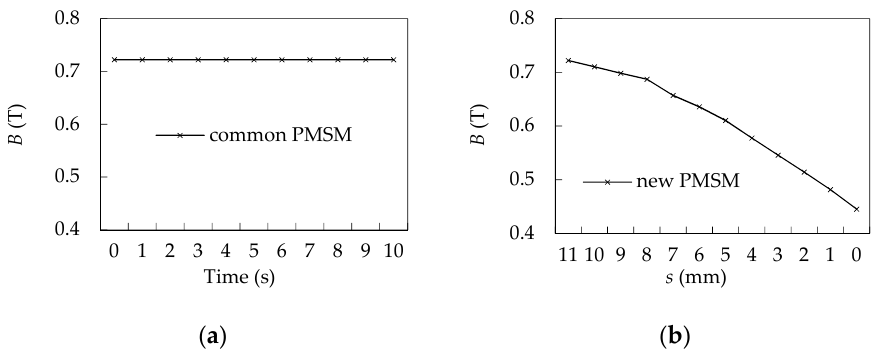
Figure 19. The no-load air-gap magnetic flux density ( n = 1500 r/min): ( a ) the magnetic flux density versus time for the common PMSM; ( b ) the magnetic flux density versus s for the new PMSM. The no-load back EMF of the common PMSM and the new PMSM is shown in Figure 20. The no-load back EMF of the common PMSM in Figure 20a is proportional to motor speed due to constant magnetic flux density. However, as the speed increases, the no-load air-gap magnetic density of the new PMSM is reduced with the increase in motor speed. As the motor speed increases, the distance s becomes smaller and the no-load back EMF is reduced, which is shown in Figure 20b. Thus, it can be seen that reducing the no-load back EMF is an alternative new way to realize FW except for applying a large negative d-axis current.